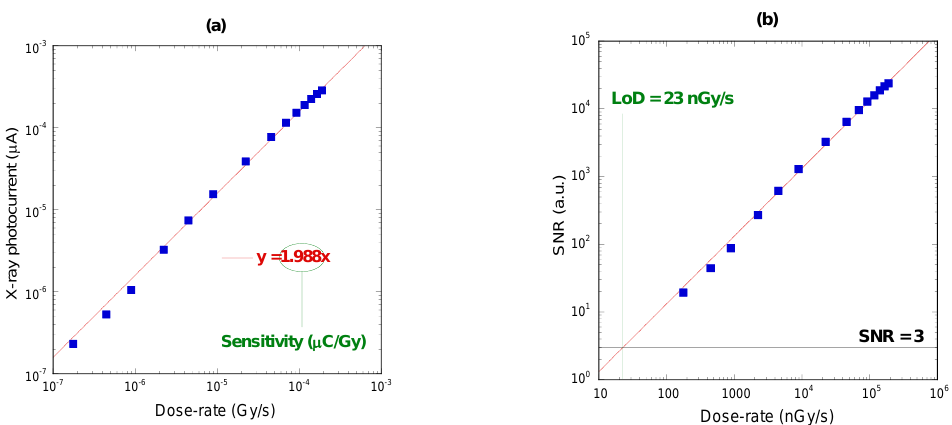
Figure 3. ( a ) Average X-ray photocurrent values as a function of the dose-rate for low-energy X-ray characterizations. Red line indicates the linear fitting curve ( ∆ = 1). Error bars, calculated as the standard deviation of the X-ray photocurrent, are smaller than the symbols; ( b ) Signal-to-noise ratio as a function of the dose-rate. The limit of detection is evaluated from the intercept of the linear fitting curve (red line) with the horizontal line corresponding to SNR = 3.